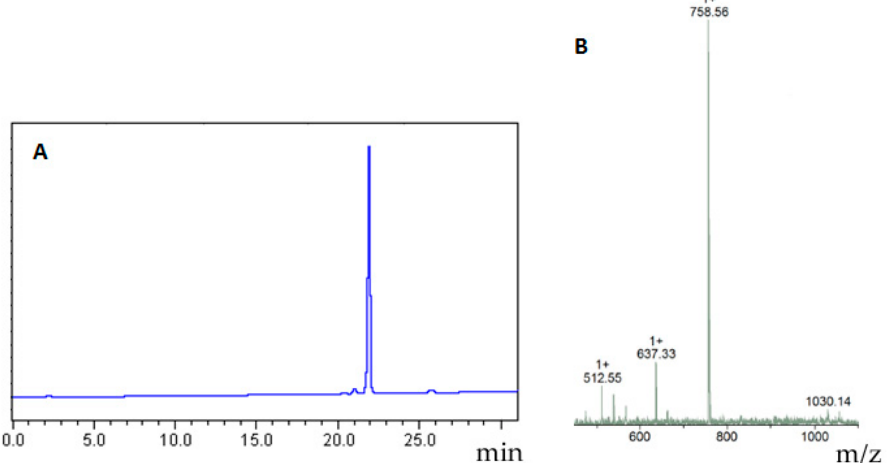
Figure 4. ( A ) HPLC analysis of purified lipid-BTH.; Column: LiChrospher ® 100 RP-18 (5 µm) LiChroCART ® 250-4; Mobile phase: THF/H 2 O; Gradient: 50% THF to 100% THF in 30 min; Flow rate: 1ml/min; Detection at 254nm; ( B ) ESI-MS of lipid-BTH.